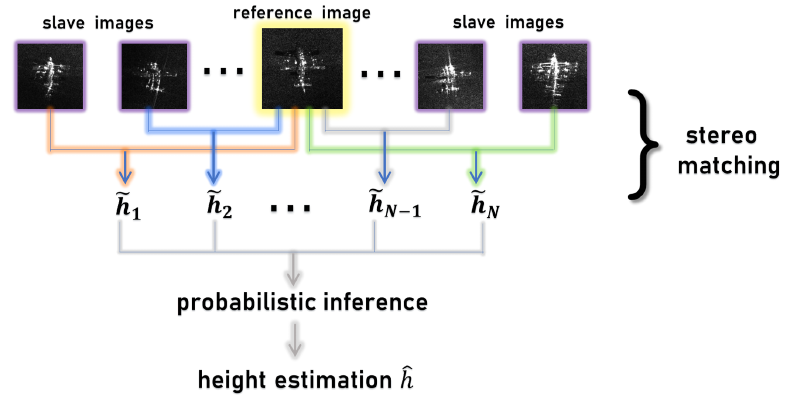
Figure 3. Processes for generating a probabilistic height